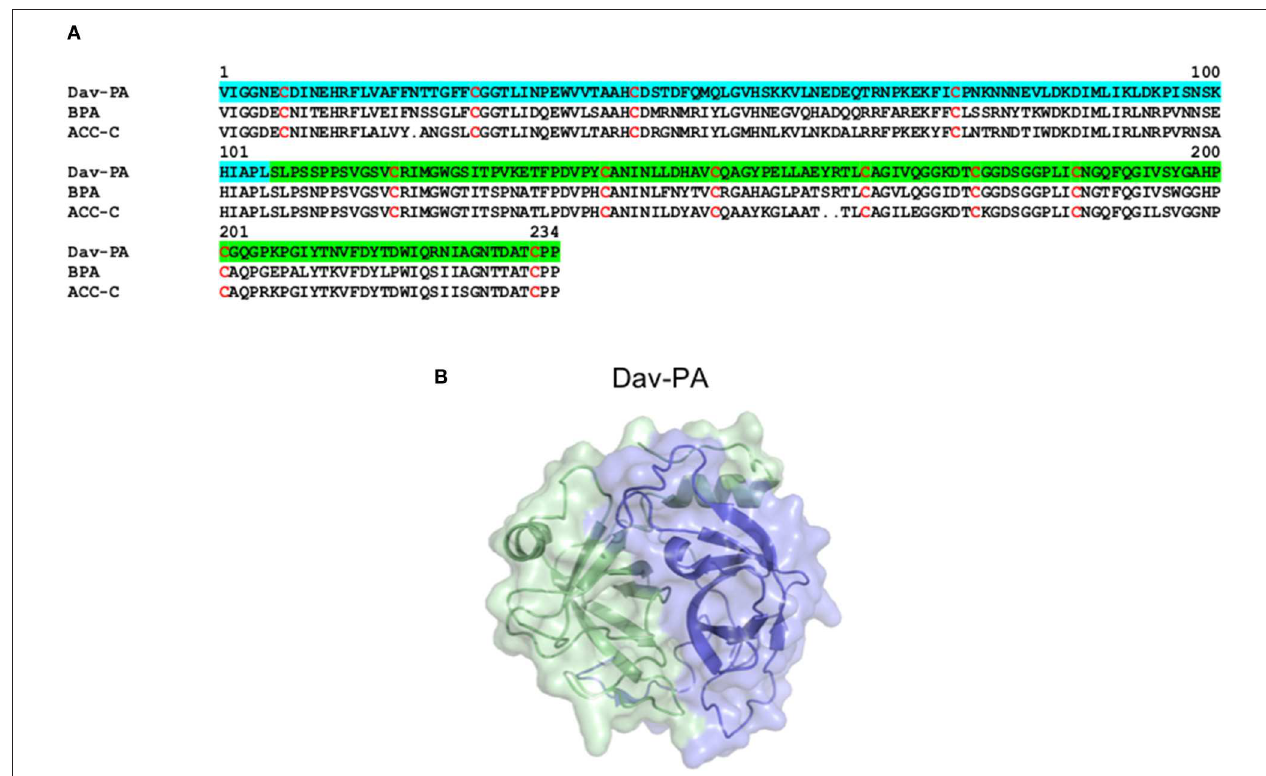
FIGURE 3 | Structure of Serine proteinases from snake venoms. (A) Alignment of the primary structure of the SVSPs Dav-PA from Deinagkistrodon acutus (Uniprot Q9I8X1), BPA from Bothrops jararaca (Uniprot Q9PTU8), and ACC-C from Agkistrodon contortrix (Uniprot P09872). In Dav-PA, the N- and C-terminal domains are highlighted in blue and green, respectively. (B) Cartoon representation of the three-dimensional structure of the SVSP Dav-PA from Deinagkistrodon acutus (PDB 1OP0), with N- and C-terminal domains colored in blue and green,